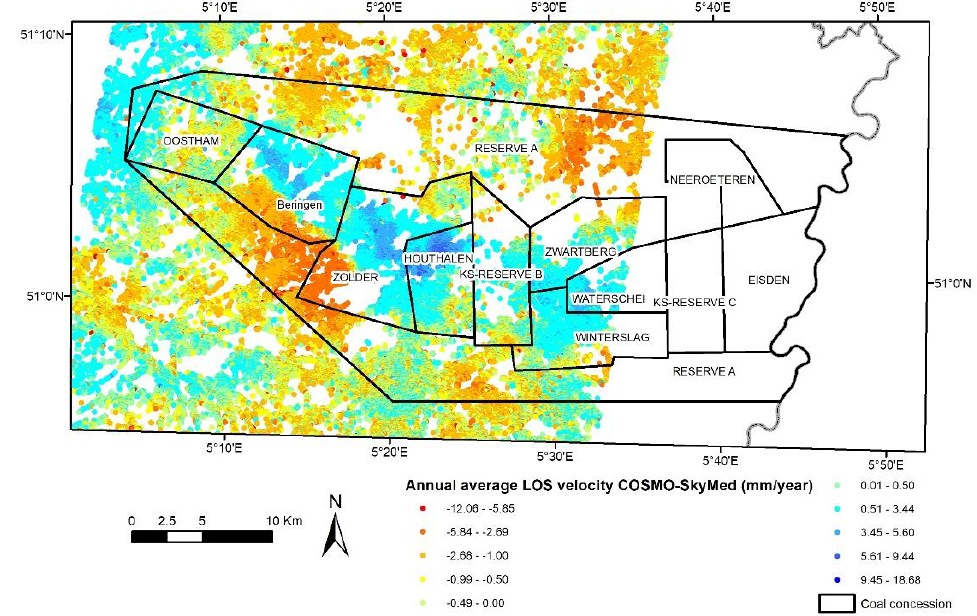
Figure 6. Color classification based on the average annual LOS velocities of PS points for COSMO- SkyMed (2011 – 2014) and the extension of coal concessions in Limburg (the eastern part of the coal basin is not covered).